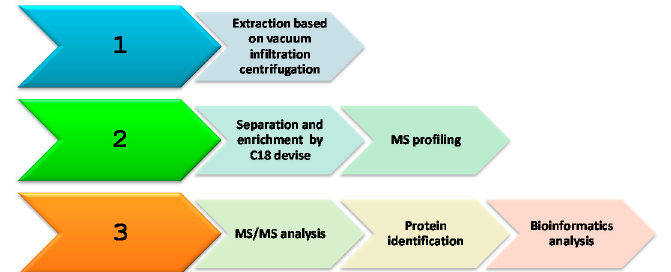
Figure 1. Schematic overview of the workflow.